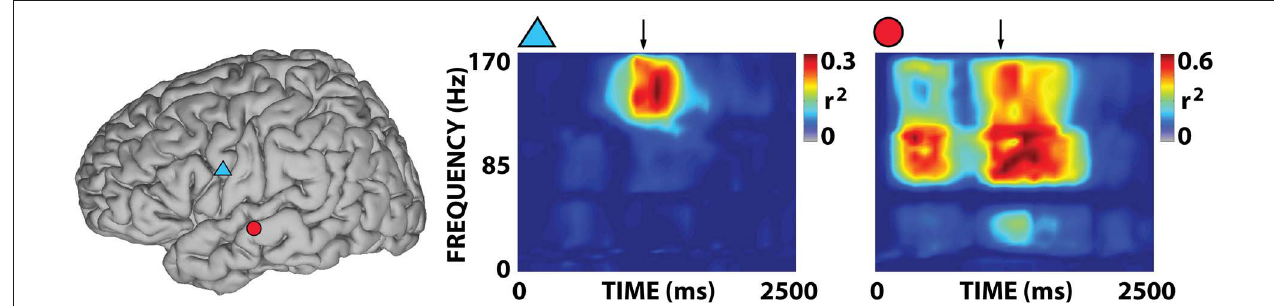
FIGURE 4 | Examples of representative r 2 time-frequency distributions for overt word repetition in response to auditory stimulation for subject A. The two time-frequency distributions were calculated for the